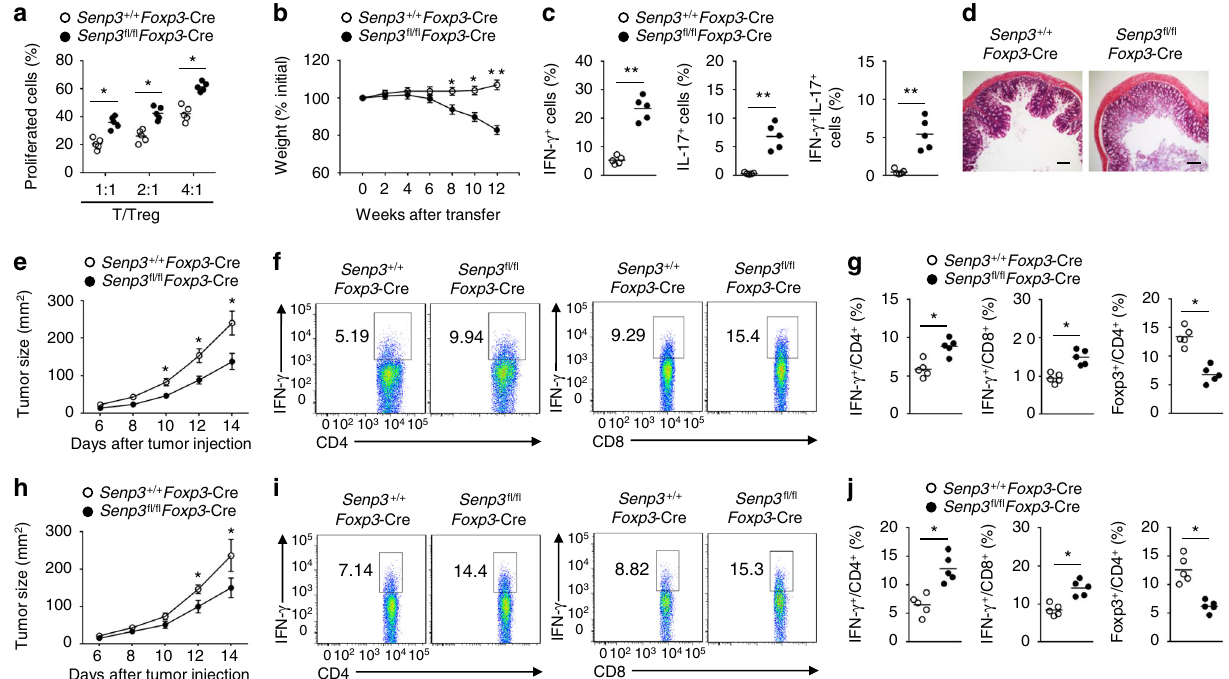
Fig. 3 SENP3 is required for the suppressive function of Treg cells. a CFSE-labeled wild-type CD4 + CD25 – YFP – T cells were cultured with the indicated number of Senp3 + / + Foxp3 -Cre or Senp3 fl / fl Foxp3 -Cre Treg cells and stimulated with anti-CD3 and anti-CD28 antibodies for three days. Summary graphs of the percentage of proliferating CFSE-labeled T cells. b – d Disease phenotype of 6-week-old RAG-1-de fi cient mice given adoptive transfer of wild-type naive CD45RB hi CD4 + T cells together with Senp3 + / + Foxp3 -Cre or Senp3 fl / fl Foxp3 -Cre Treg cells. Body weight was presented relative to initial weight ( b ). Frequency of cytokine-producing CD4 + T cells in the mesenteric lymph nodes ( c ) or hematoxylin-eosin staining of colon sections ( d ) from recipient mice at 12 weeks after adoptive transfer. Bars, 500 μ m. e Tumor growth in Senp3 + / + Foxp3 -Cre or Senp3 fl / fl Foxp3 -Cre mice subcutaneously (s.c.) injected with B16-F10 melanoma cells ( n = 8). f , g Flow cytometric analysis of the frequency of IFN- γ -producing CD4 + and CD8 + T cells or Foxp3 + CD4 + T cells in tumors of Senp3 + / + Foxp3 -Cre and Senp3 fl / fl Foxp3 -Cre mice (day 14 after B16-F10 tumor injection). h Tumor growth in Senp3 + / + Foxp3 -Cre or Senp3 fl / fl Foxp3 -Cre mice subcutaneously (s.c.) injected with MC38 colon cancer cells ( n = 8). i , j Flow cytometric analysis of the frequency of IFN- γ -producing CD4 + and CD8 + T cells or Foxp3 + CD4 + T cells in tumors of Senp3 + / + Foxp3 -Cre and Senp3 fl / fl Foxp3 -Cre mice s.c. injected with MC38 colon cancer cells (day 14). Data are representative of at least three independent experiments. Error bars are the mean ± SEM values. n = 5 or 8. Two-tailed unpaired Student ’ s t tests were performed. * P < 0.05; ** P <